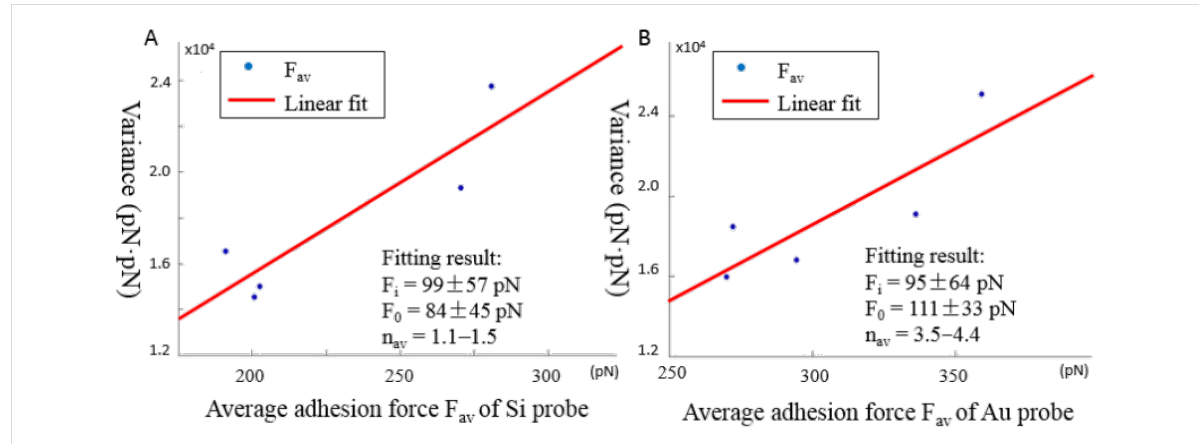
Figure 3: Linear fit of average adhesion force F av against its variance by using the Poisson statistical method for (A) the Si probes and (B) the Au-coated probes, respectively. The fitting result is also shown as inset, in which F i is the specific interaction, F 0 is the non-specific interaction, and n av is the average number of interacting molecules.